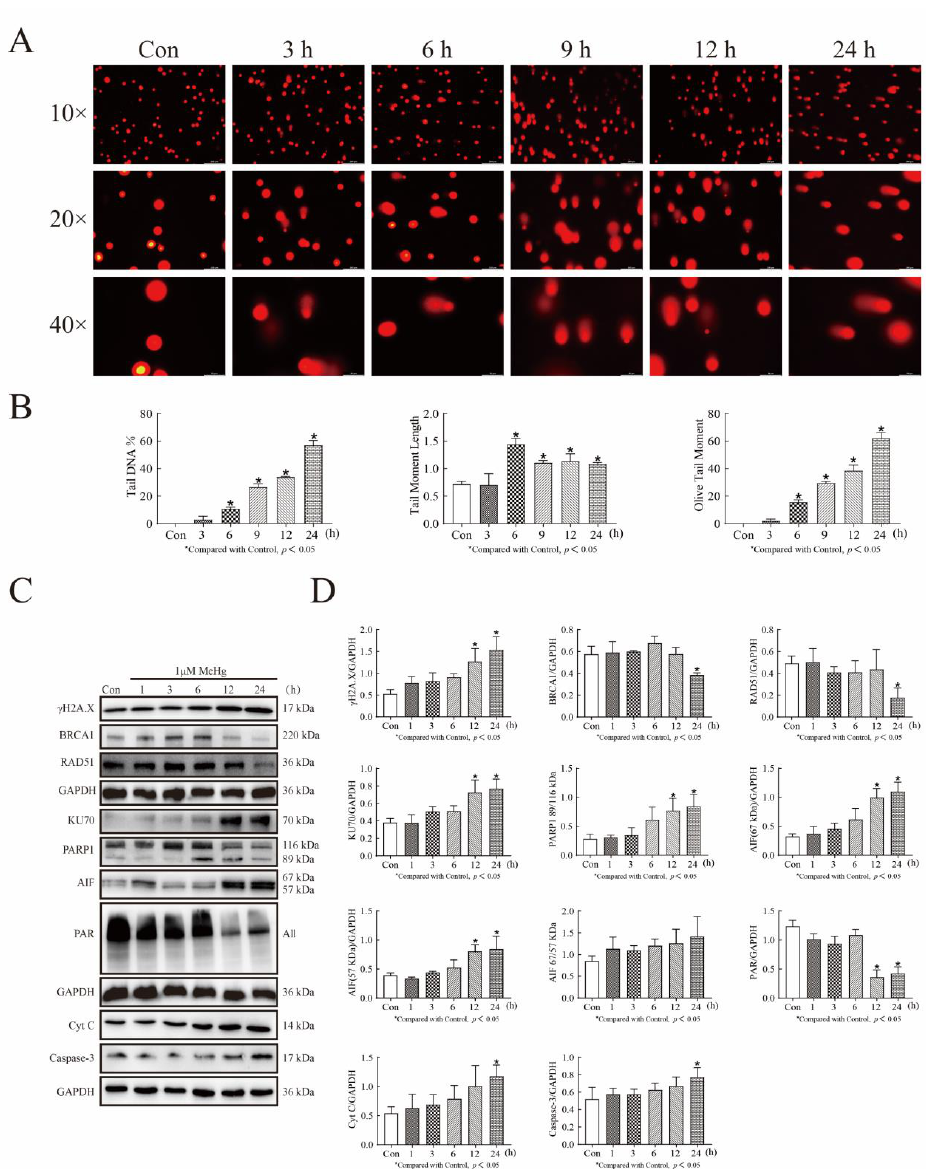
Figure 3. MeHg induces DNA damage and participates in both NHEJ repair and induced apoptosis in SH-SY5Y cells ( A ) The alkaline comet assay detects cell trailing in 1 μM MeHg -treated SH-SY5Y cells from 0 – 24 h. The images were photographed with a Leica fluorescence microscope. ( B ) CASP software analyses of comet image and the Olive tail moment can be used to determine the extent of DNA damage. ( C ) Western blot analysis detected the protein expression levels of γH2AX, BRCA1, RAD51, KU70, PARP1, AIF, PAR, Cyt C, and cleaved Caspase-3 in SH- SY5Y cells treated with 1 μM MeHg from 0 – 24 h. ( D ) The Tanon-2500 fully automated digital gel image analysis system was used to analyze the net optical density of the Western blot strips. The mean was calculated using GraphPad Prism 8.0.2 software. The data shown represent the mean from one of three independent experiments. Statistical significance was determined using variance (ANOVA). All values are rep- resented as means ± SD ( n = 3). Superscript denotes a statistically significant difference between groups ( p < 0.05). Abbreviations: BRCA1 and RAD51, homologous repair-associated repair proteins; HR, homologous recombination; KU70, non-homologous end joining-associated repair protein; NHEJ, nonhomologous end joining; γ H2AX, phosphorylated histone